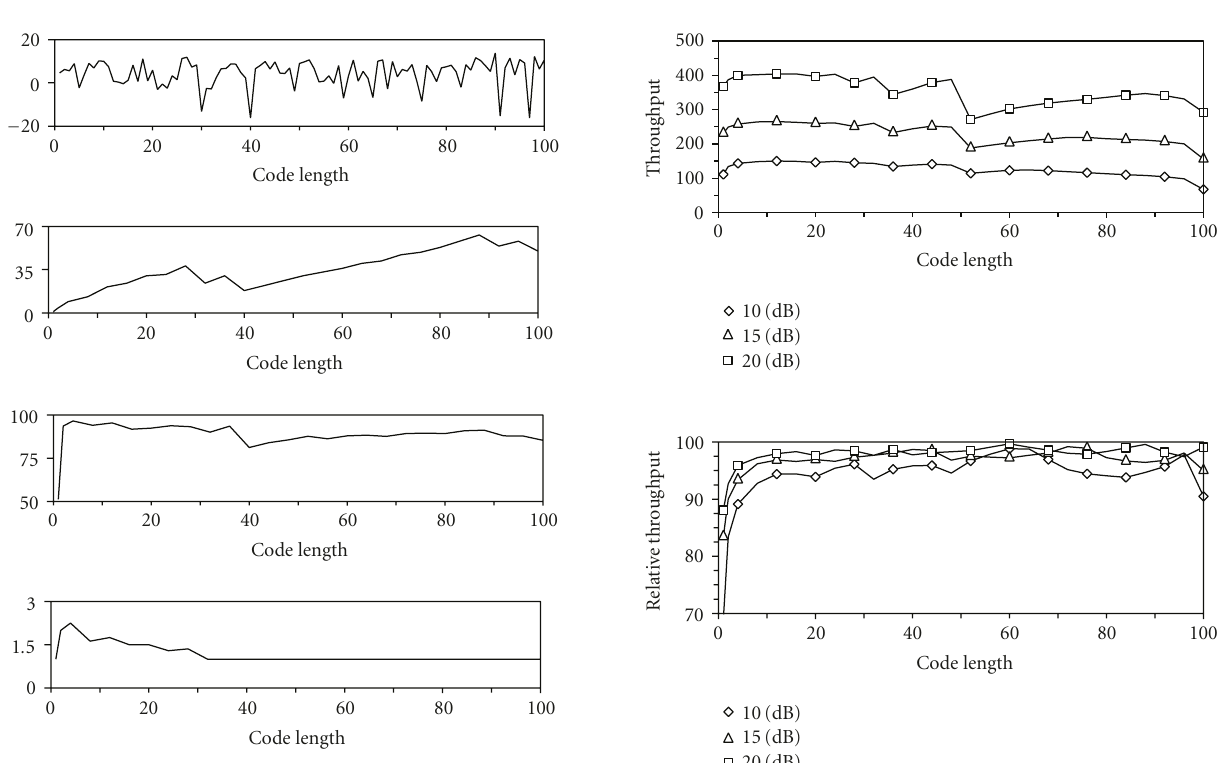
Figure 5: Throughput R in bit per SS-OFDM symbol and relative throughput R/ R in percent versus code length L f = L over 100 subcarriers, for 3 average SNR { 10,15,20 } dB, and Γ =